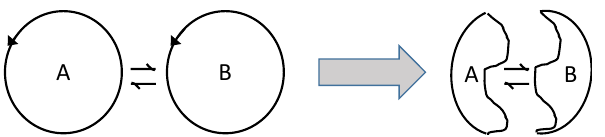
Figure 1. Emergence of structural coupling. Adapted from [19]